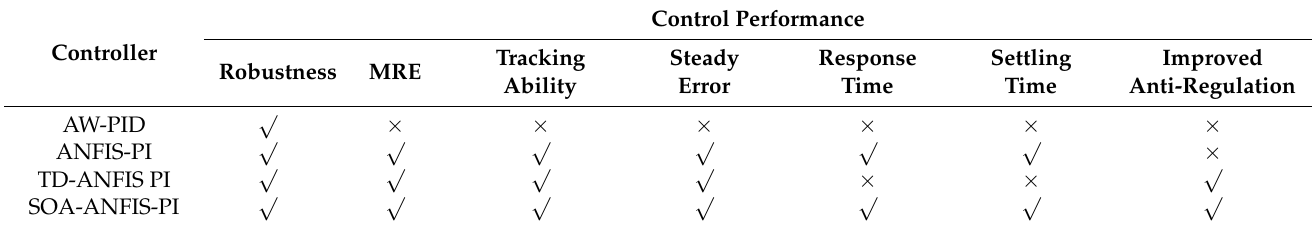
Table 5. Comparative performance analysis of considered